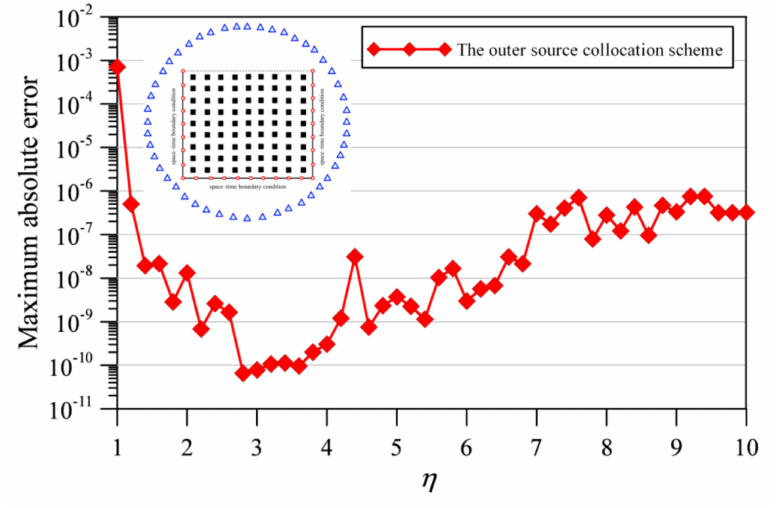
Figure 5. The maximum absolute error versus the dilation